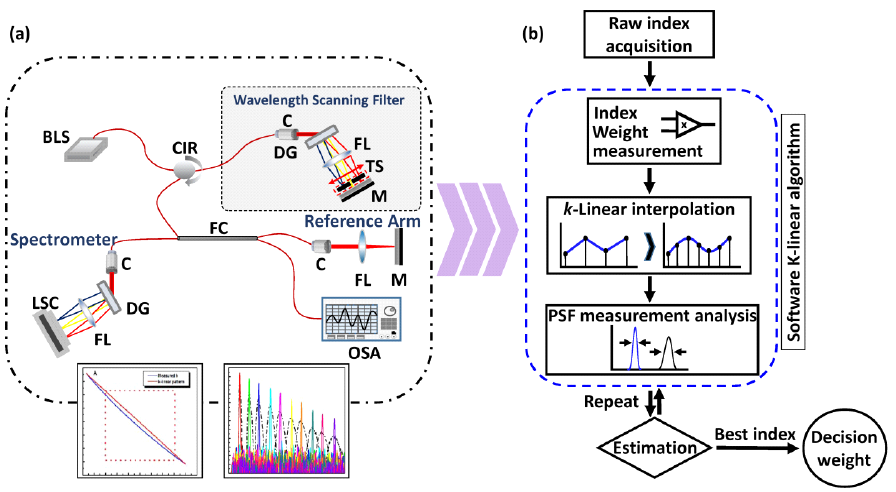
Figure 2. ( a ) Schematic of OCT-hybrid wavelength scanning filter. ( b ) Architecture of the proposed direct real-time k -domain modeling algorithm. (BLS: broadband laser source; C: collimator; CIR: circulator; DG: diffraction grating; FC: fiber coupler; FL: focusing lens; GS: galvanometer scanners; LSC: line-scan camera; M: mirror; OSA: optical spectrum analyzer; S: sample; TS: translation slit).